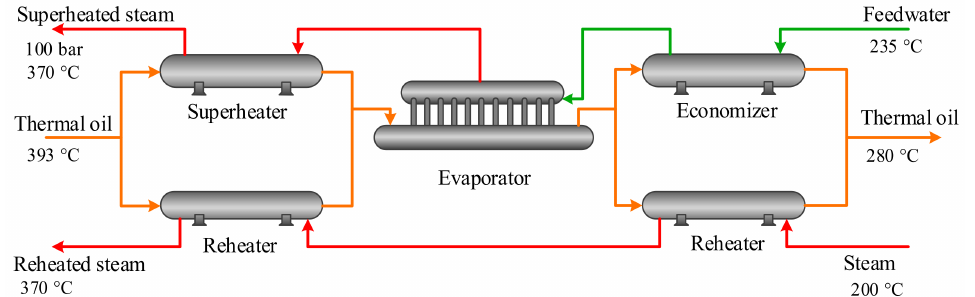
Figure 7. A general layout of the steam generation and steam reheating system of the 50 MW CSP plant.